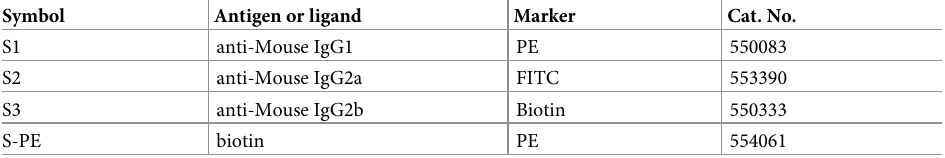
Table 2. Data of secondary antibodies.